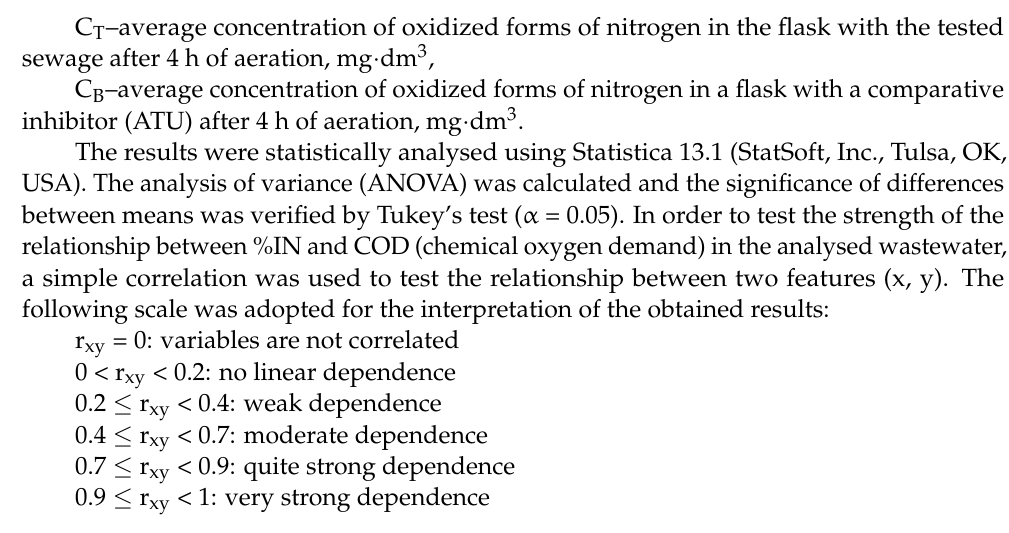
Table 2. Technological parameters of the activated sludge used for the research. Parameter Unit Value